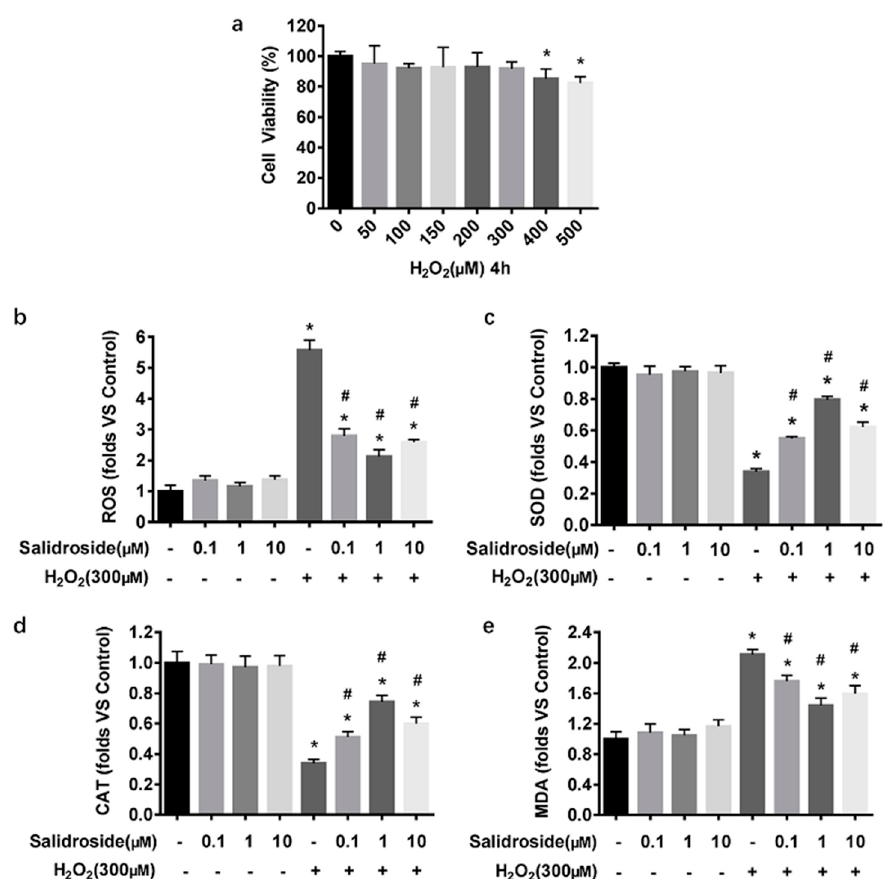
Figure 3. SAL reduces H 2 O 2 -induced ROS production and MDA formation and increases the activities of antioxidant enzymes in HUVECs. ( a ) HUVECs were treated with various concentrations of H 2 O 2 (0–500 µ M) for 4 h, and cell viability was determined by MTT assay. ( b – e ) HUVECs were incubated without any intervention (control), SAL (0.1, 1, 10 µ M) for 24 h, or 300 µ M H 2 O 2 for 4 h, or 0.1, 1, 10 µ M SAL for 24 h followed by 300 µ M H 2 O 2 for an additional 4 h. ( b ) Intercellular ROS levels: Intercellular ROS levels were determined by DCFH-DA fluorescence. After various treatment, the cells were stained with 10 µ M DCFH-DA in serum free medium for 30 min in the dark. Fluorescence intensity was recorded using a Synergy TM 4 Multi-Mode Microplate Reader at an excitation wavelength of 488 nm and an emission wavelength of 525 nm. ( c – e ) SOD, CAT activities, and MDA content: SOD, CAT activities, and MDA content were measured using respective assay kits. Data are presented as mean ± SD values of three independent experiments. * p < 0.05 vs. control. # p < 0.05 vs. H 2 O 2 -treated HUVECs.